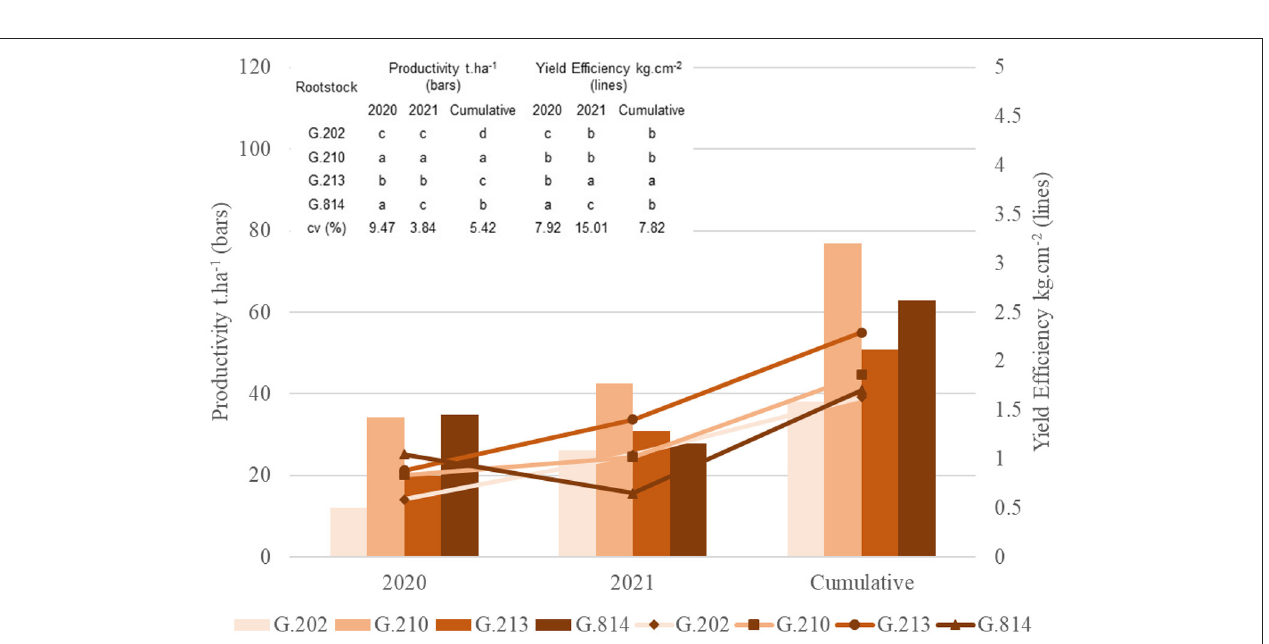
FIGURE 1 | Yield and yield efficiency of the Gala Select cultivar grafted on different rootstocks, under replanting area in São Joaquim. Yield and yield efficiency that do not share a letter are significantly different (Tukey’s test, α = 0.05).